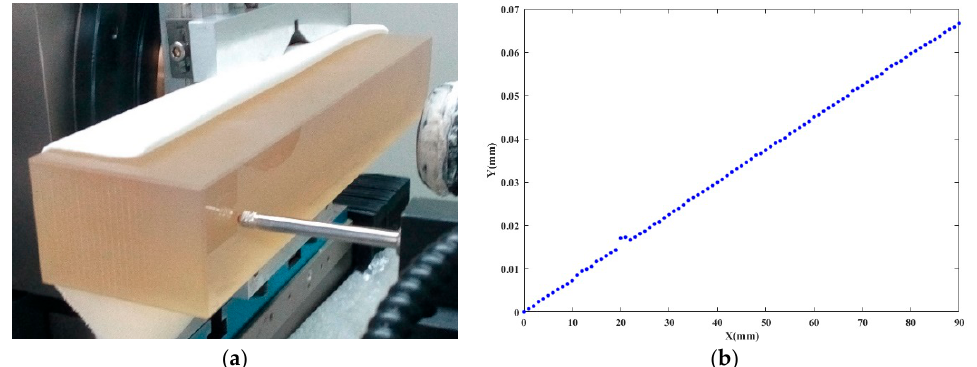
Figure 9. The measurement experiment of optical flat. ( a ) Measurement for optical plat; Figure9. Themeasurementexperimentofopticalflat. ( a )Measurementforopticalplat;( b )Measurementdata ( b ) Measurement data of optical plat. of optical